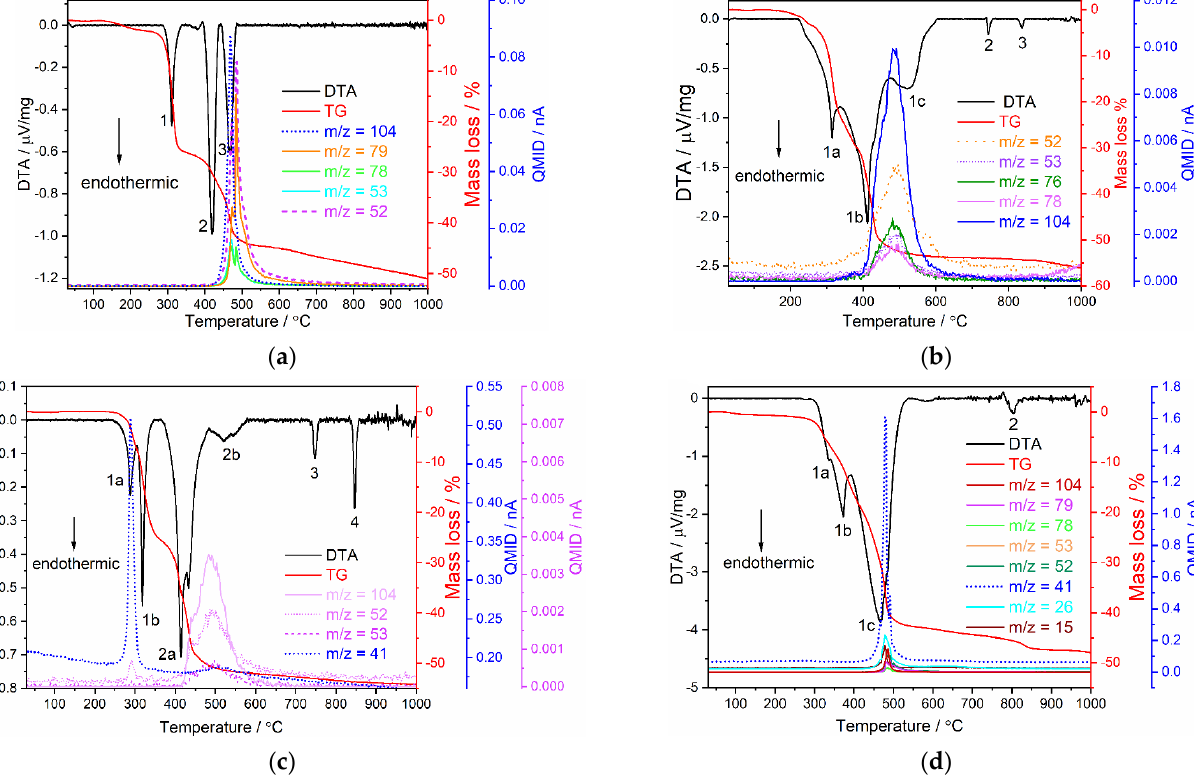
Figure 9. Simultaneous DTA/TG analysis together with mass spectrometry of ( a ) 1 ∞ [Sm 2